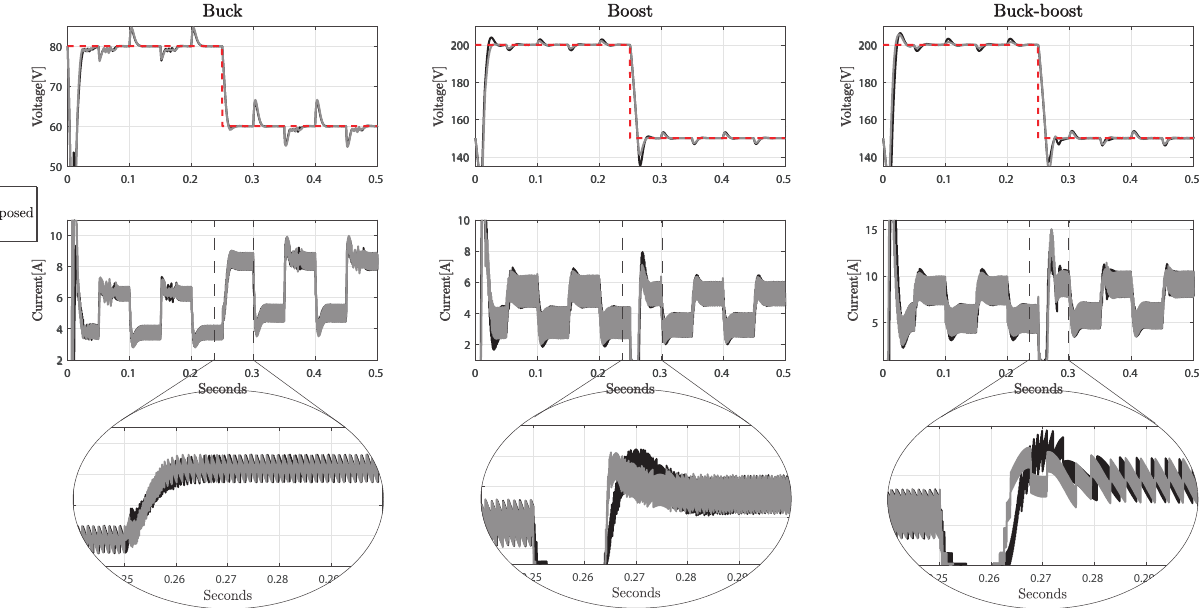
Figure 9. Power demand for bounded and time-varying case based on CLP problem. This case considered the nominal value for V in = 100 V and P ( t ) as a square signal with amplitude ∈ [ 300 500 ] W and frequency of 10 Hz to simulate. The upper figures indicate the given power and the power demand of the CPL. The lower figures show a zoom of the step-changes in power demand.